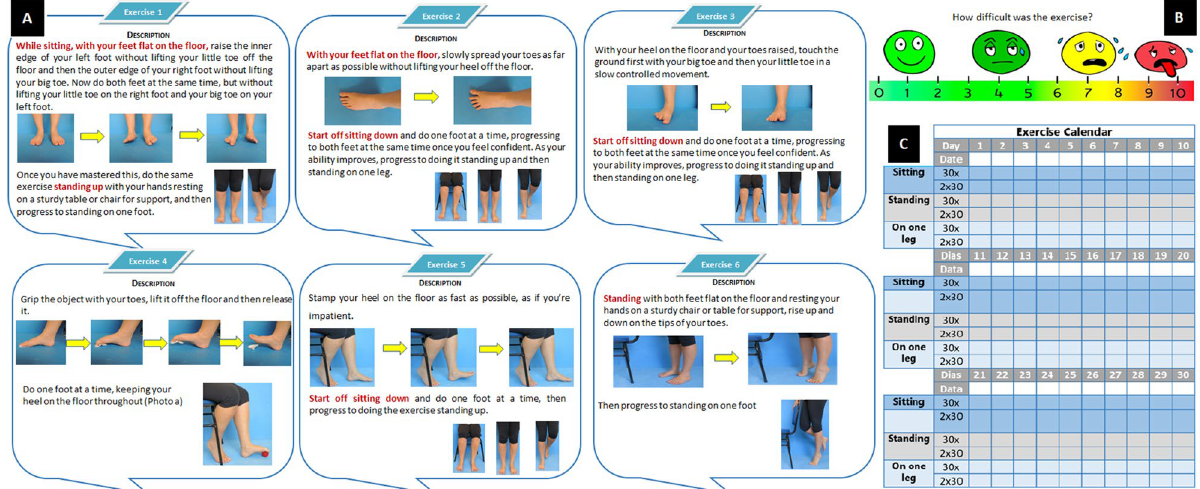
Figure 4. A sample of pages from the booklet. ( A ) exercise programme, ( B ) level of difficulty and ( C ) monthly- calendar. The booklet was created using Adobe Photoshop cs5 Windows (https:// www. adobe. com/ br/ produ